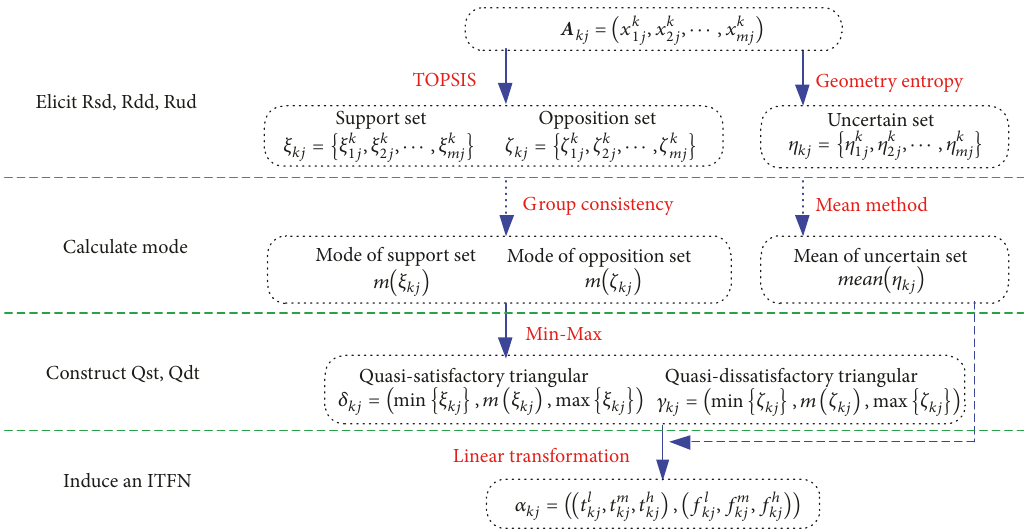
Figure 1: Framework for aggregating